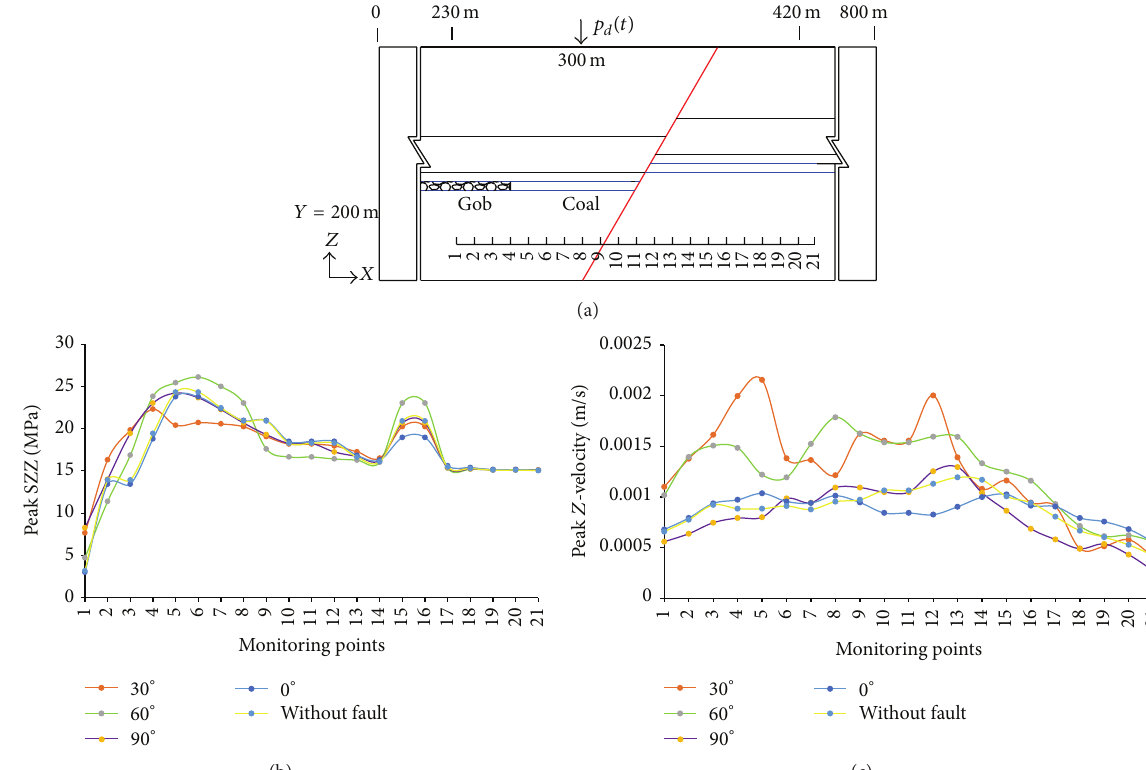
Figure 8: Curves of peak vertical stress and velocity of monitoring points: (a) monitor locations; (b) peak SZZ; and (c) peak 𝑍 -velocity.